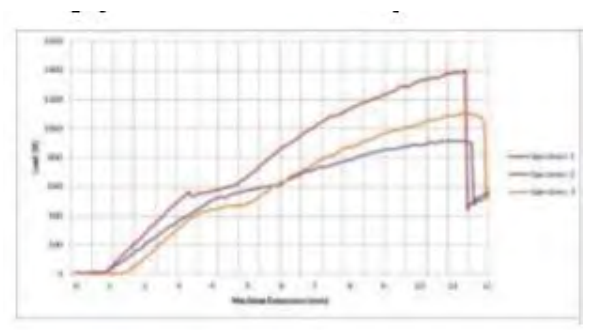
Figure 36. Graphs of the apparent Modulus of Elasticity of span 220 mm (Author’s own, n.d.)